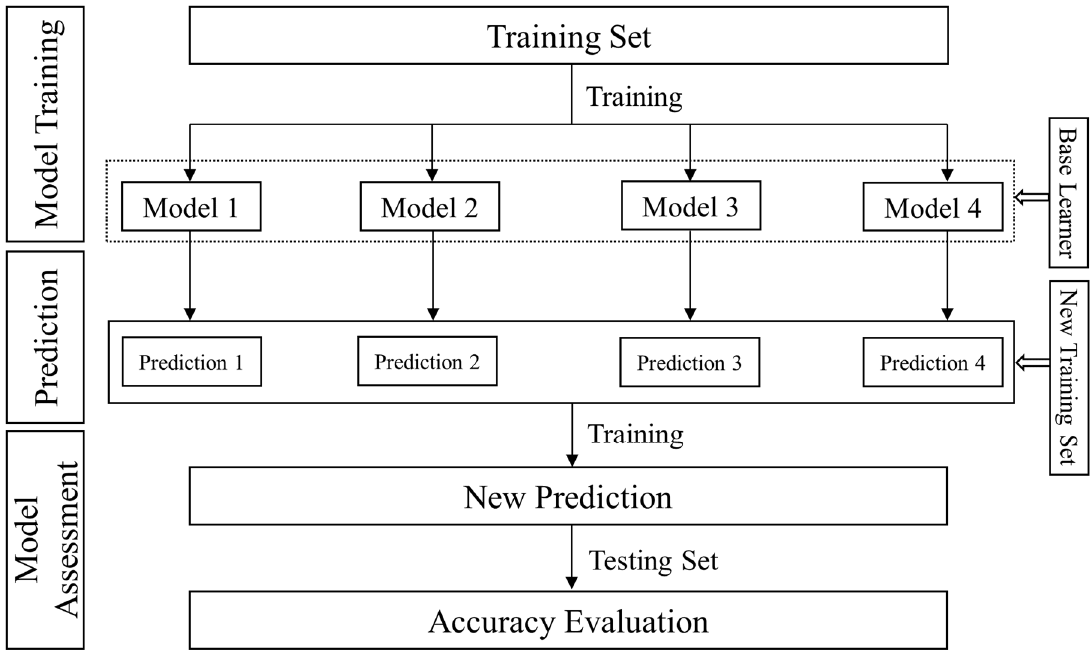
Figure 4. The framework of the stacking algorithm.